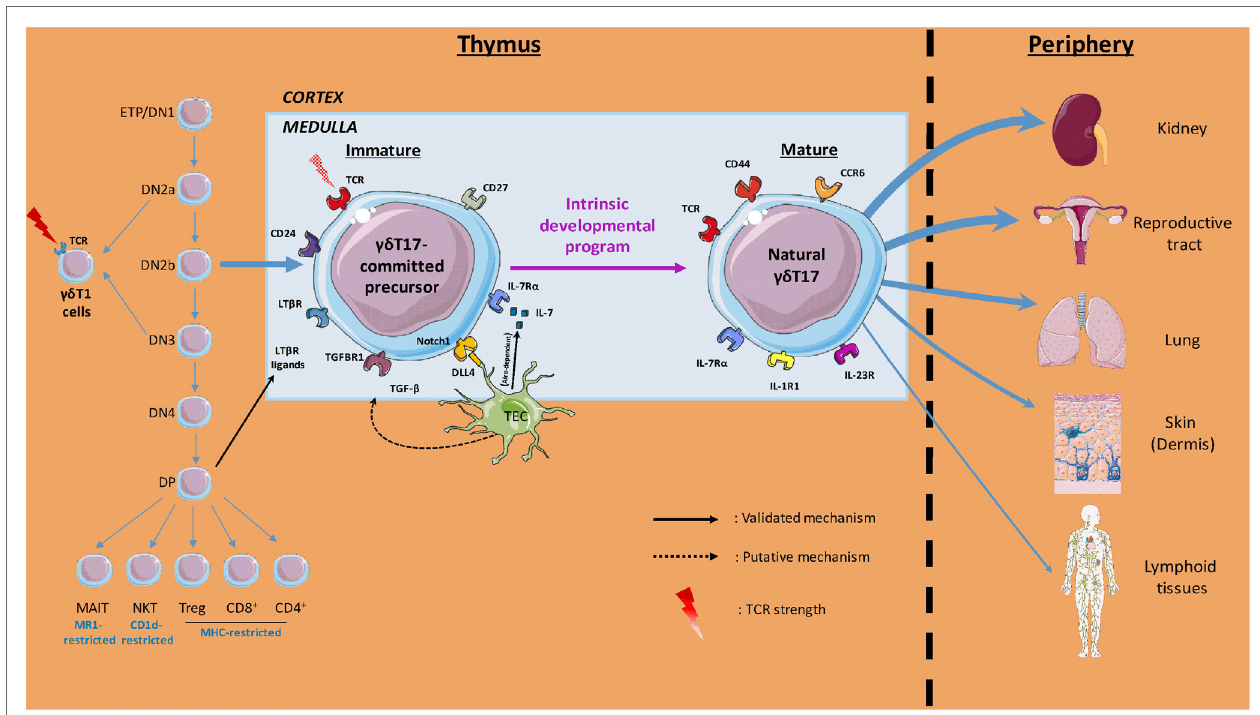
FiguRe 1 | Overview of thymic γδ T17 cell ontogeny. Initial intrathymic pathways leading to pre-committed γδ T17 cells divergence from other T cell lineages are illustrated. The thymic (cortical and medullary) environmental cues involved in γδ T17 cell effector fate and the preferential peripheral niches of mature γδ 17 cells are also depicted. Labels indicate the cells, soluble factors, proteins, surface markers, and T cell receptor (TCR) signal strength involved in the γδ T17 cell program of